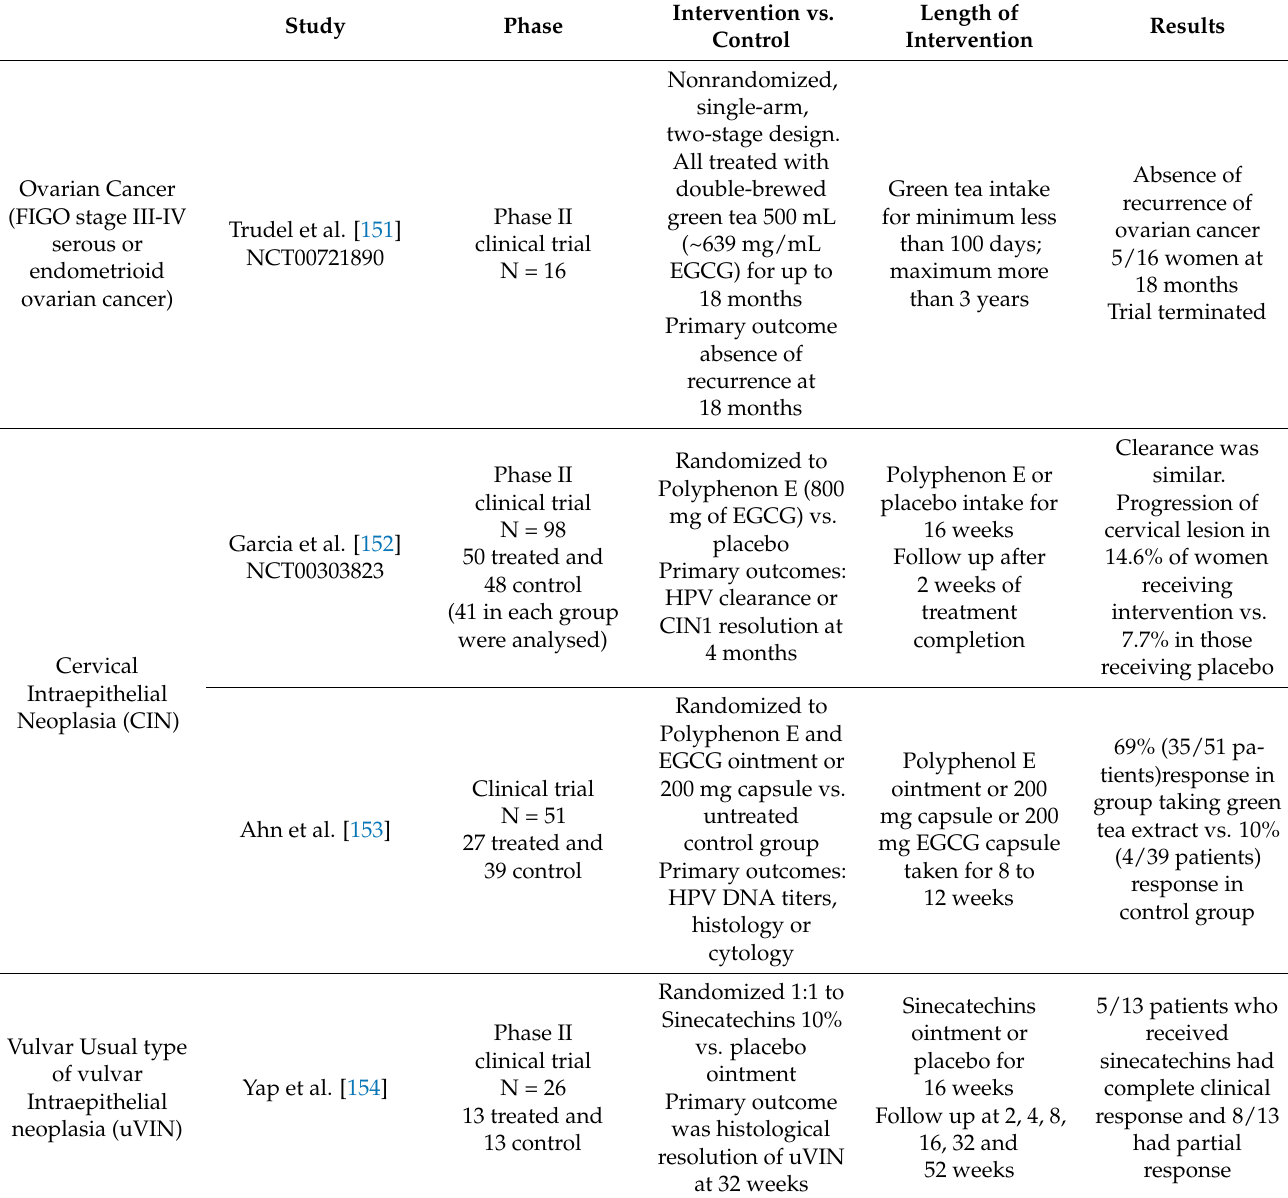
Table 4. Interventional trials studying the effect of green tea on reproductive cancers. Intervention Phase